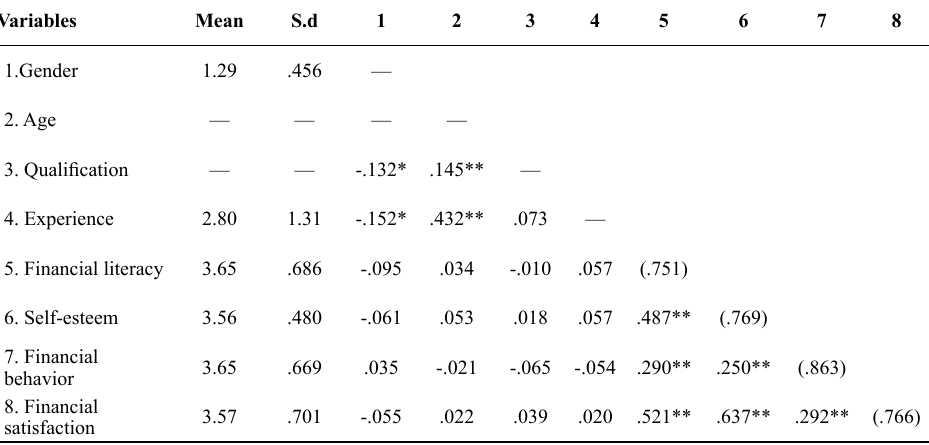
Means, Standard Deviations, Correlations and reliability analysis Variables